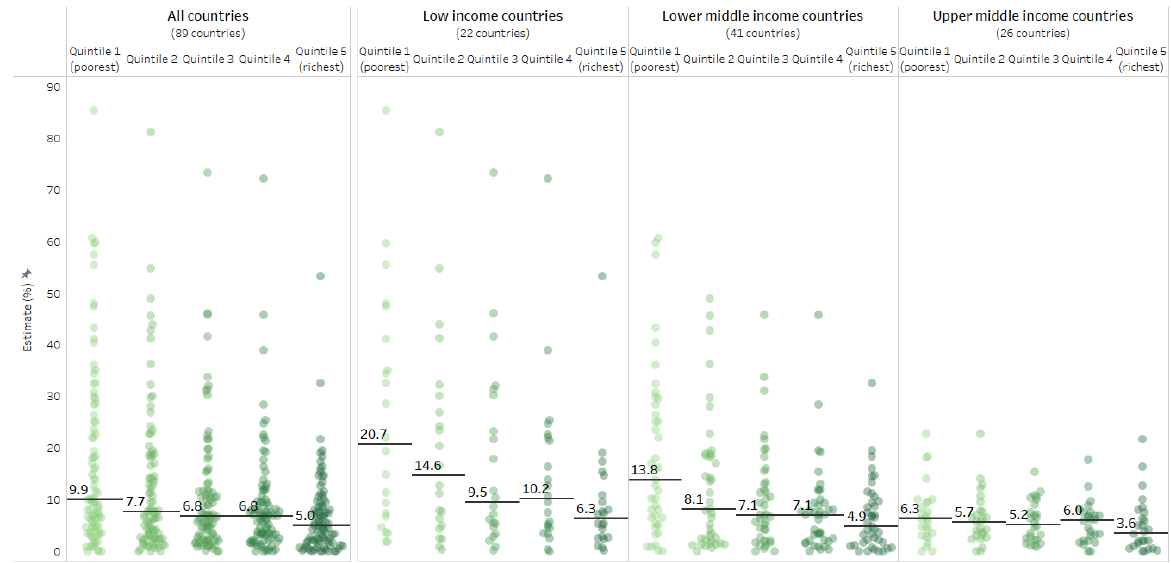
Figure 1. Percentage of children aged 12–23 months who did not receive any doses of DTP-containing vaccine in 89 countries, zero-dose DTP, disaggregated by economic status and grouped by country income level. Data taken from DHS and MICS 2010 – 2019. Circles indicate wealth quintile subgroups within countries; the horizontal lines indicate the median value across countries. Countries classified according to 2021 World Bank country income level groupings. DHS = Demographic and Health Survey. DTP = diphtheria – tetanus – pertussis vaccine. MICS = Multiple Indicator Cluster Survey.